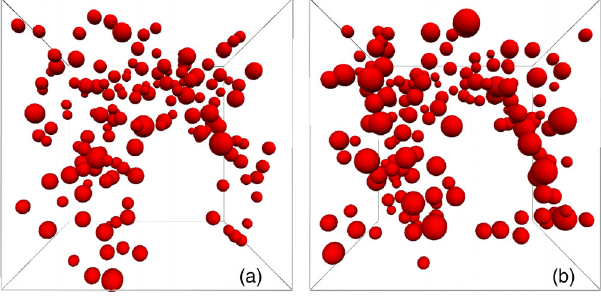
FIG. 13. Snapshots of the 10% of particles with (a) the largest displacements and (b) the largest diameter change, computed between times t ¼ 0 and t ¼ τ α = 2 for T ¼ 0 . 0555 . There is a clear correlation between the spatial regions where dynamics in real and diameter spaces are fast, but the correlation is weak at the single-particle